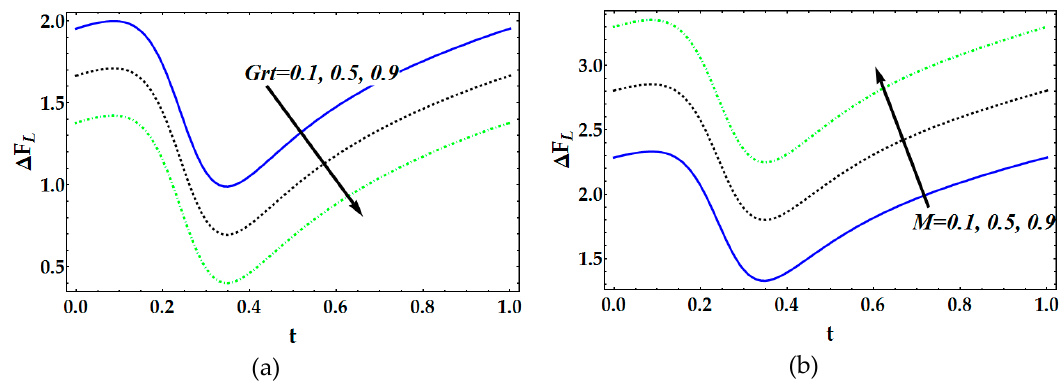
Figure 5. Pressure distribution for various values of M and friction force profile for various values of G rf .